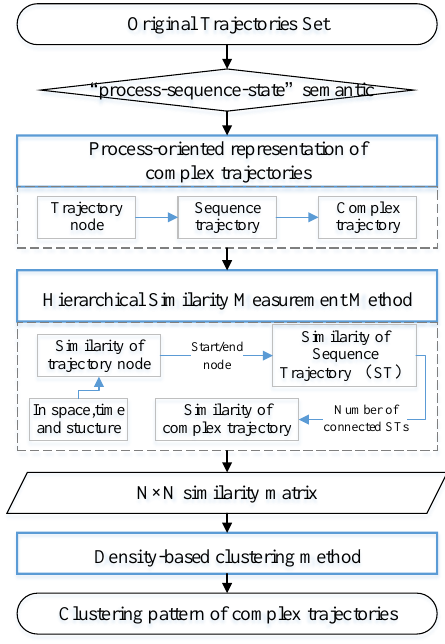
Figure 2. The overall framework of the